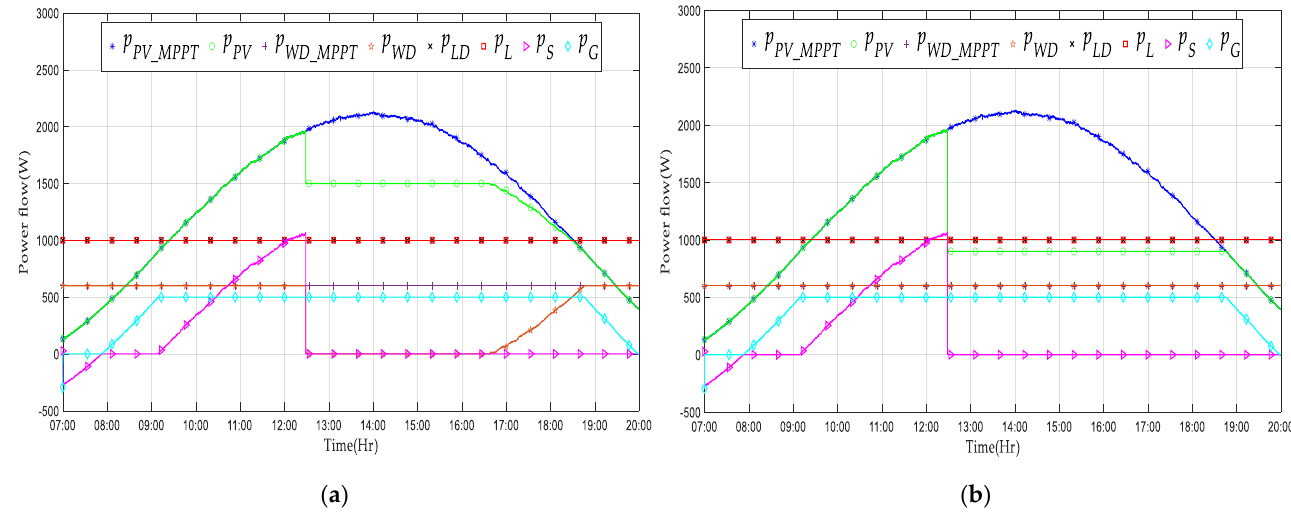
Figure 15. Power flow curves with optimization by applying the γ coefficient in the case of: ( a ) c PVS > c WDS ; ( b ) c PVS < c WDS